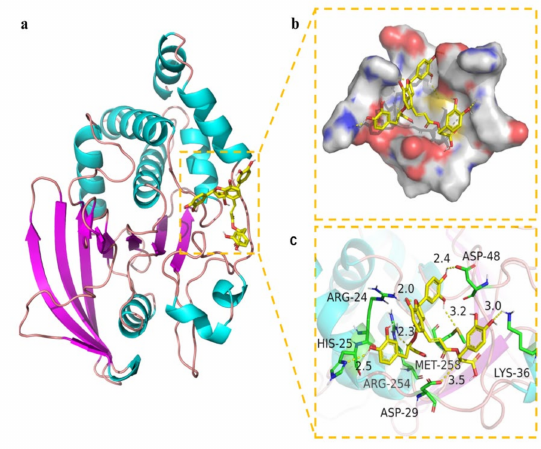
Figure 8. Binding mode of salvianolic acid B to PTP1B. ( a ) The 3D structure of the complex. ( b ) The surface of active site. ( c ) The detail binding mode of the complex. The backbone of protein was rendered in tube and colored in bright blue. Salvianolic acid B compound was rendered in yellow. The yellow dash represents hydrogen bond